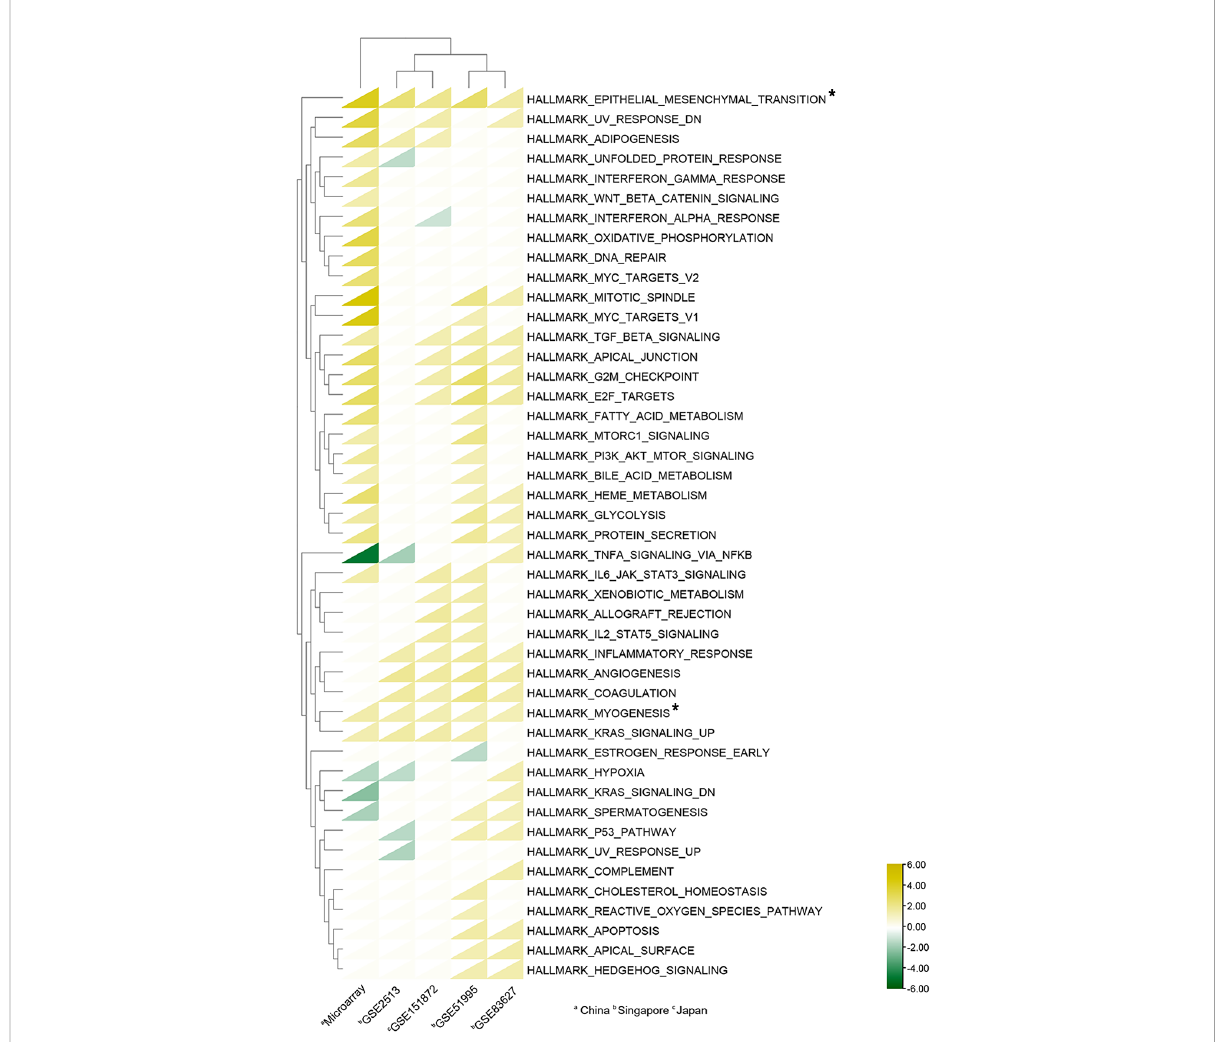
FIGURE 4 Heat map of Gene sets enriched in GSEA analysis. A total of 45 gene sets were enriched. The triangles in yellow indicate upregulated gene sets (NES > 0), while the triangles in green indicate downregulated gene sets (NES < 0); Triangles in white show no enrichment. Asterisks mean gene sets enriched in all datasets. The cluster analyses were based on Euclidean